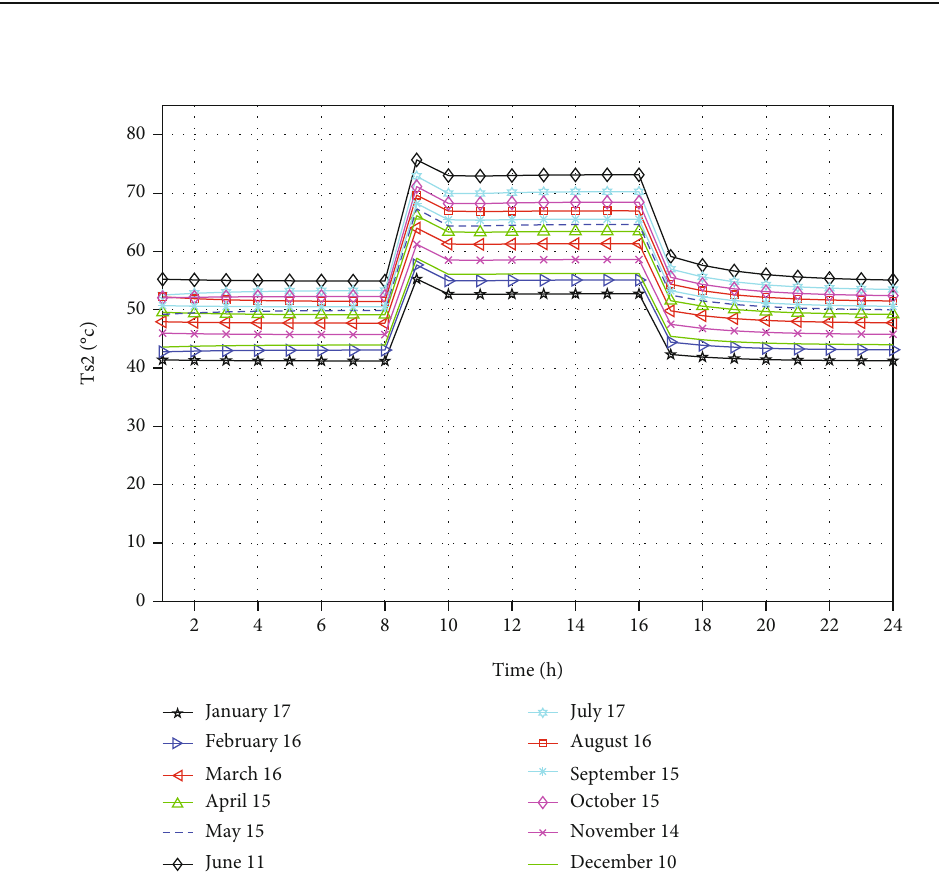
Figure 10: Water temperature with 75% electrical energy supply during 8 hours of water supply hours and 25% during the